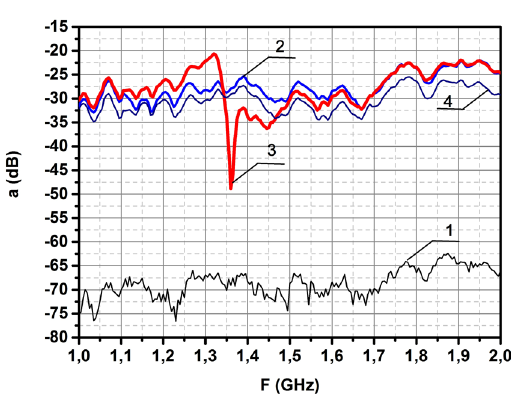
Figure 3. Experimental spectra for the arrangement of dielectric ring, depicted in Fig. 1a. The distance between antennas is 30 cm. Spectra 1 , 2 , 3 show the level of noises, the level of radiation without the ring and level of radiation in the centre of ring respectively. The resonant dip at the frequency ω 0 = 15.1 GHz is recorded. To the contrary, the spectrum of brass ring (curve 4 ) doesn’t display the resonant behaviour.